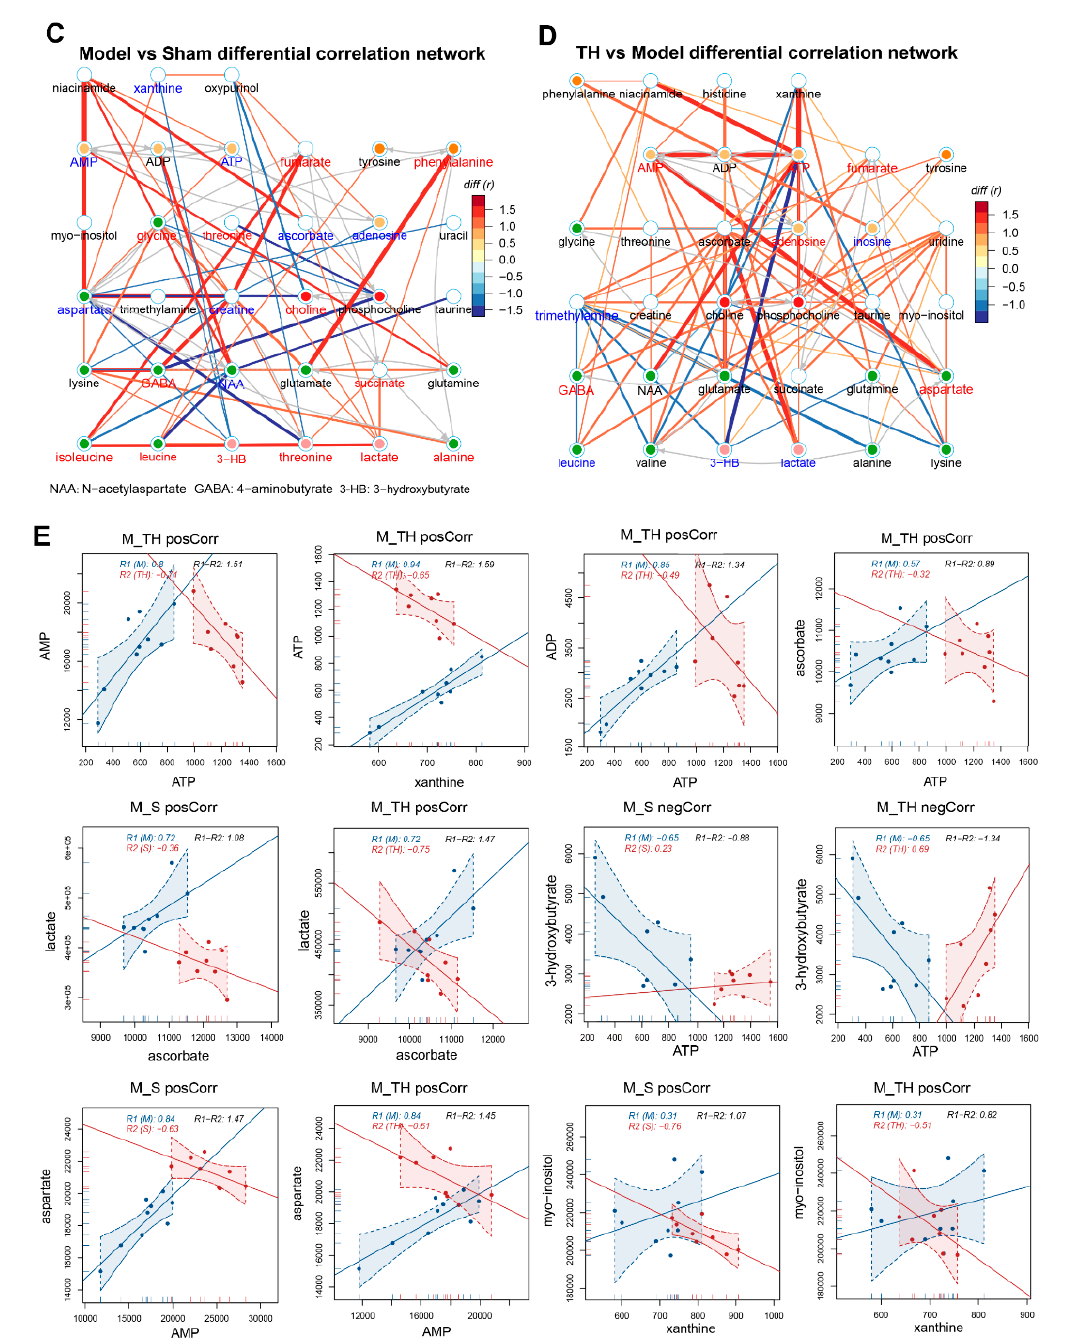
Figure 3. Metabolomics pathway and correlation network analysis of TSG putative targets. ( A , B ) Impact of pathways enriched on the disturbed metabolites and predicted targets of TSG in bubble plots. The color of each circle is based on p -values (darker colors indicate more significant changes of metabolites in the corresponding pathway), whereas the size of the circle corresponds to the pathway impact score. The most impacted pathways with high statistical significance scores are annotated. ( C , D ) Differential correlation network analysis of brain metabolic profiles between the sham, model and TH groups. Metabolites with Pearson’s correlations coefficients over 0.65 and p -values less than 0.05 are connected by solid lines that are color coded according to the values of the coefficients; a warm color represents a positive correlation, and a cool color represents a negative correlation. The width of each line was scaled based on its absolute values. The names of the metabolites shown in red and blue indicated that they are significantly increased and decreased, respectively. The gray lines between the metabolites indicated direct biological reactions. ( E ) Scatter plots of correlated metabolites. Each point represents one sample. R1 and R2 indicate the Pearson coefficient between two metabolites in each two